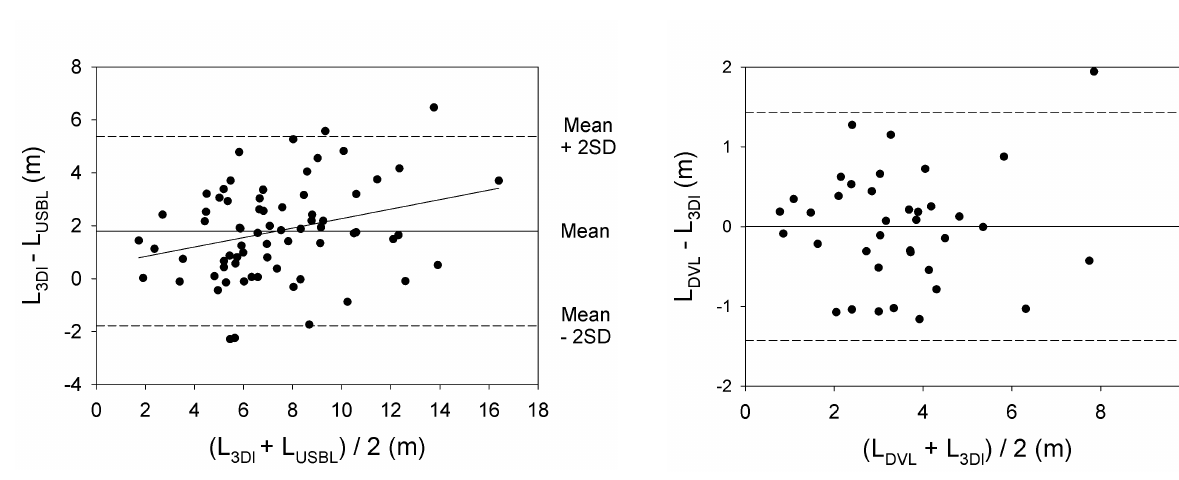
Fig. 9. Bland and Altman plot of difference against mean for the subtransect length measured from bottom tracking ( L DVL ) and the linear subtransect length in PhotoModeler ( L 3Dl ).